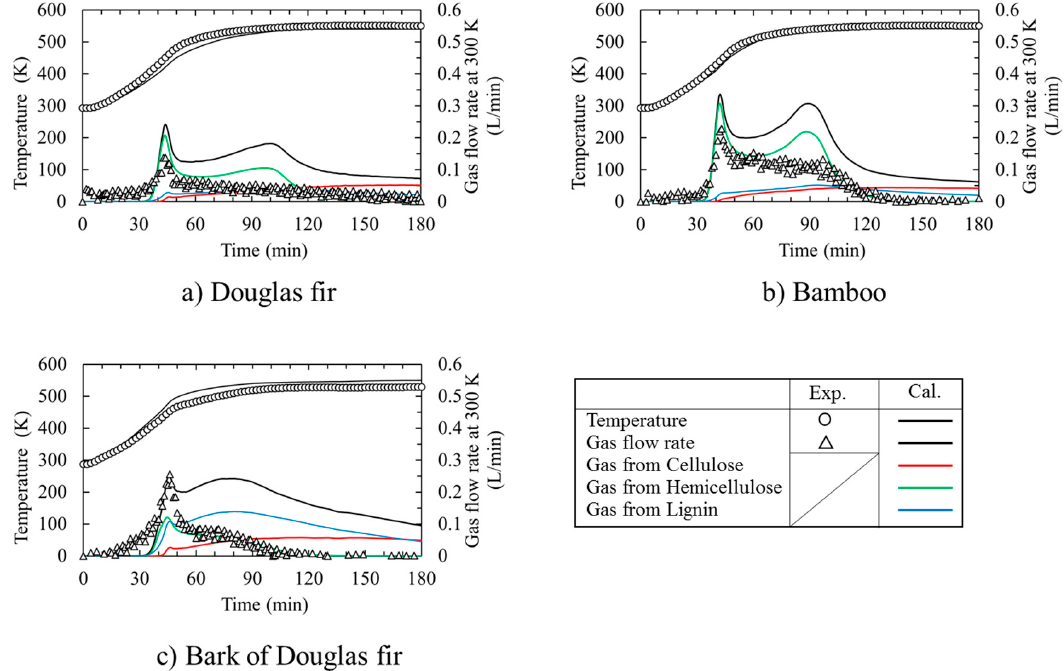
Figure 5. Time course of the temperature and generated gas flow rate during the biomass torrefaction.